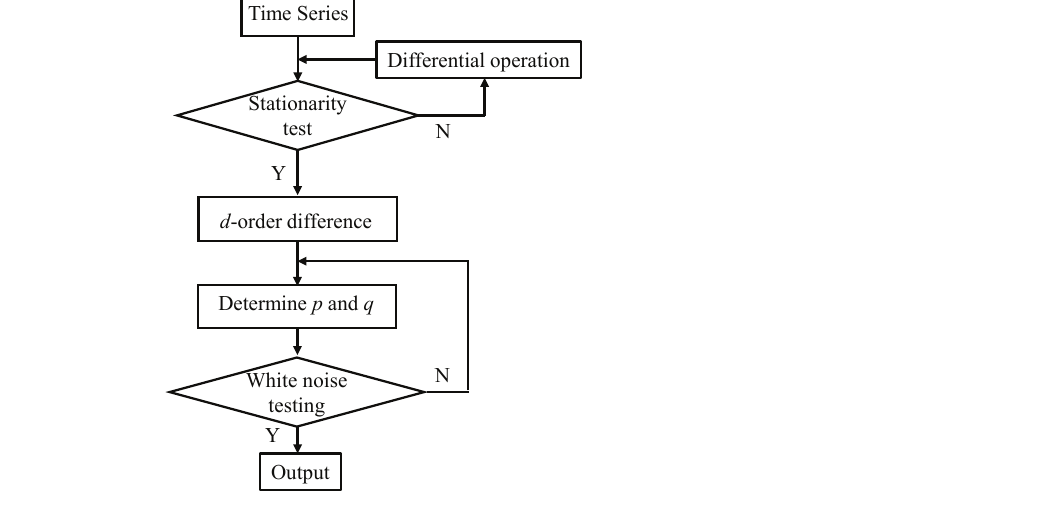
Figure 1. The flowchart of the auto-regressive integrated moving average (ARIMA)